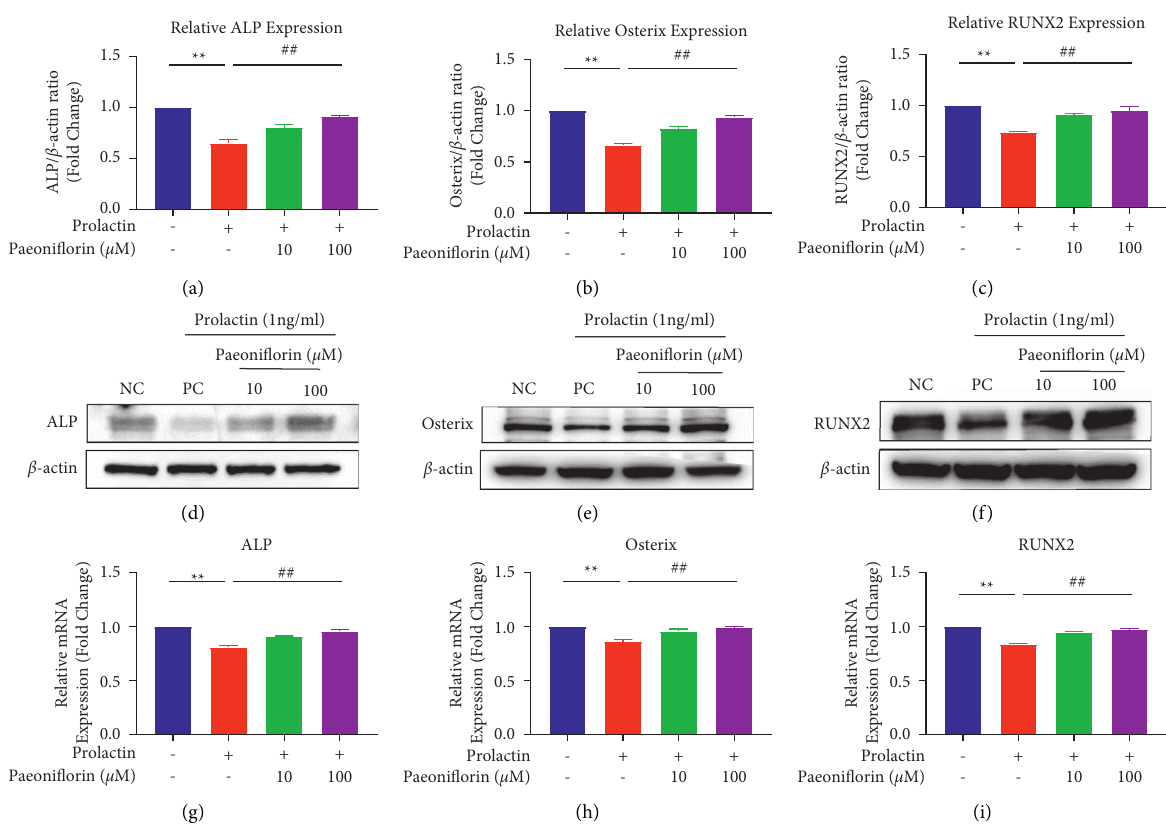
Figure 4: Paeoniflorin rescued hyperprolactinemia-induced inhibition of osteoblast-related protein and gene expression. (a–c) Quantification of the osteoblast-related proteins ALP, Osterix, and RUNX2. (d–f) Cell lysates were subjected to WB analysis with antibodies against these proteins. (g–i) Quantification of the mRNA expression of ALP , Osterix , and RUNX2 . n � 3; ∗∗ P < 0 . 01, ∗ vs the NC group; ## P < 0 . 01, # vs the PC